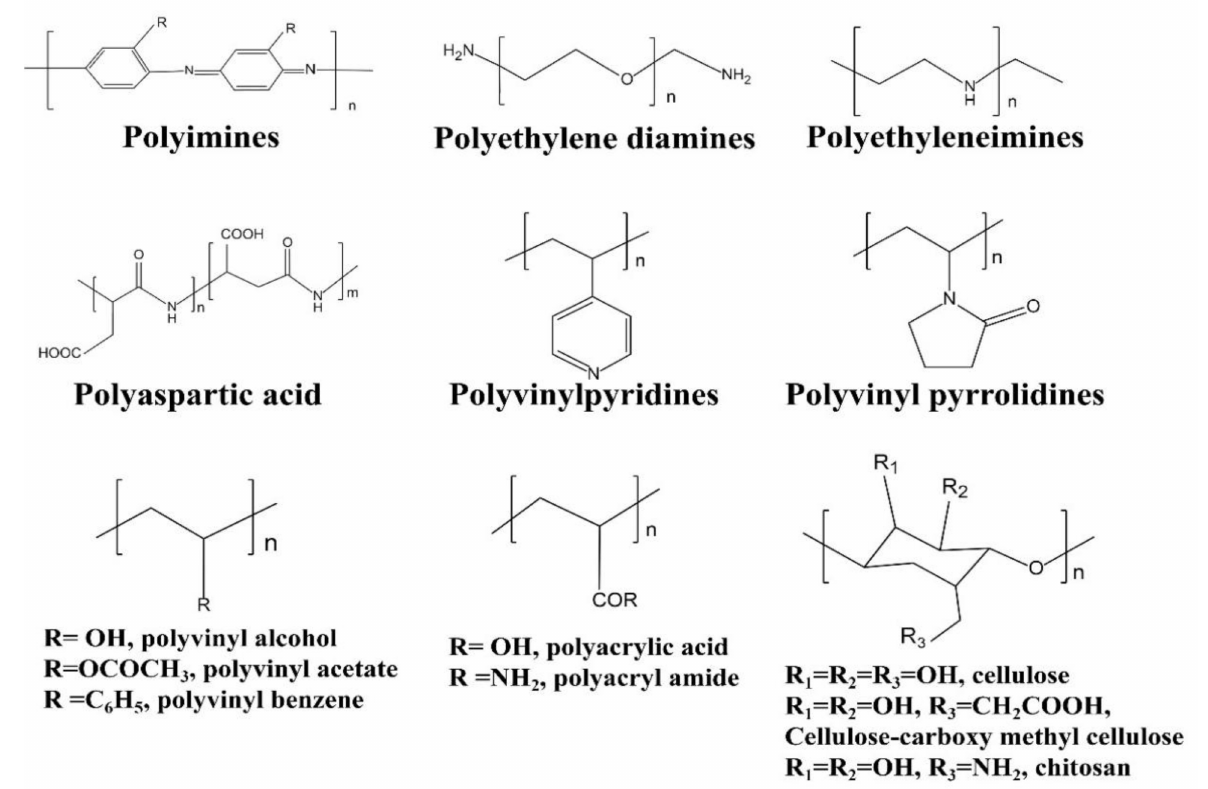
Figure 13. Structural groups of polymer